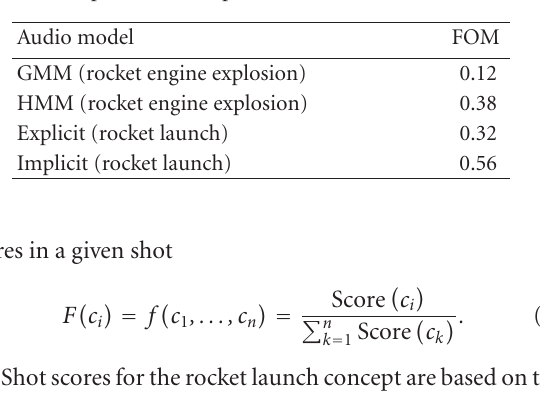
Table 3: FOM results: audio retrieval, GMM versus HMM perfor- mance and implicit versus explicit fusion.